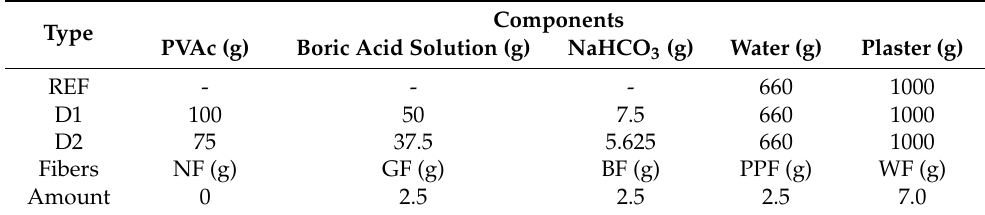
Table 4. Dosages used. PVAc—polyvinyl